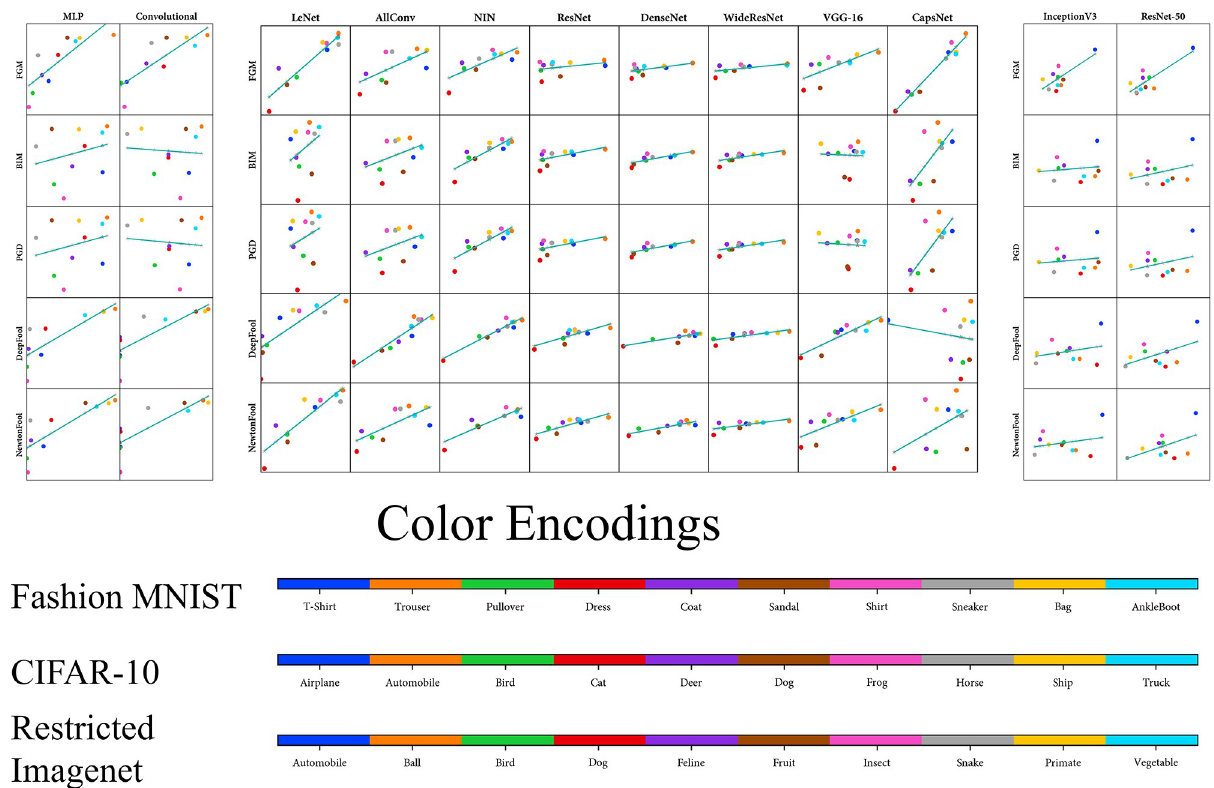
Fig 6. Visualisation of Pearson correlation of Amalgam Metric (AM) with Mean L 2 Score of adversarial attacks (Table 3). Here, the x-axis represents the Mean L 2 Scores while the y-axis represents the AM values. Each point represent an AM value and Mean L 2 Score for a labelled class.